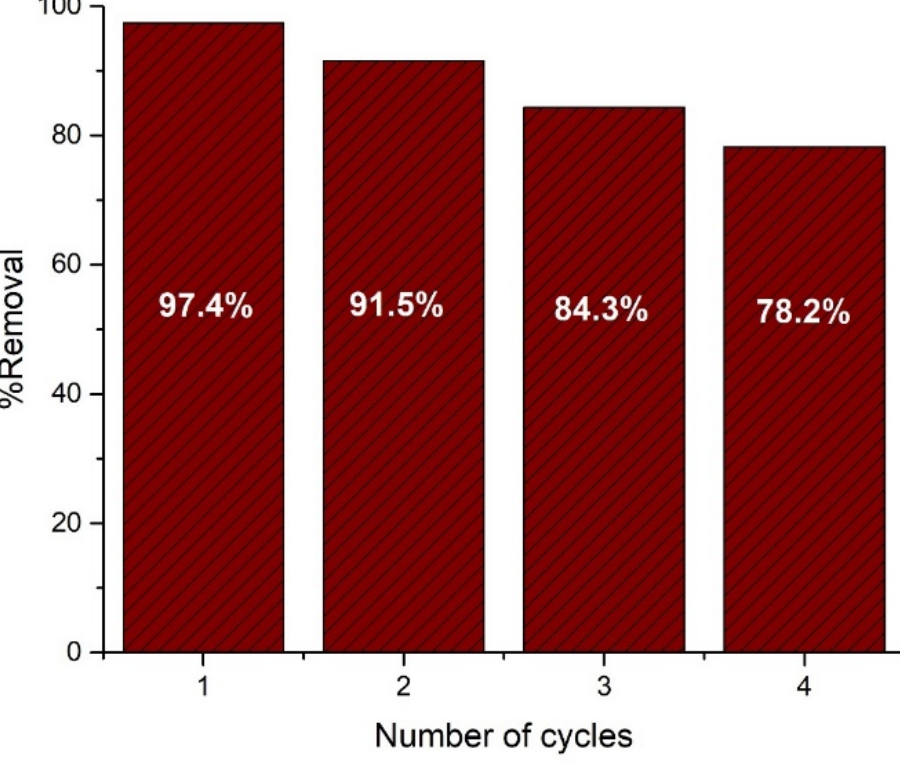
Figure 14. Demonstration of reusability of the nanohybrid for the removal of Orange G up to four cycles.